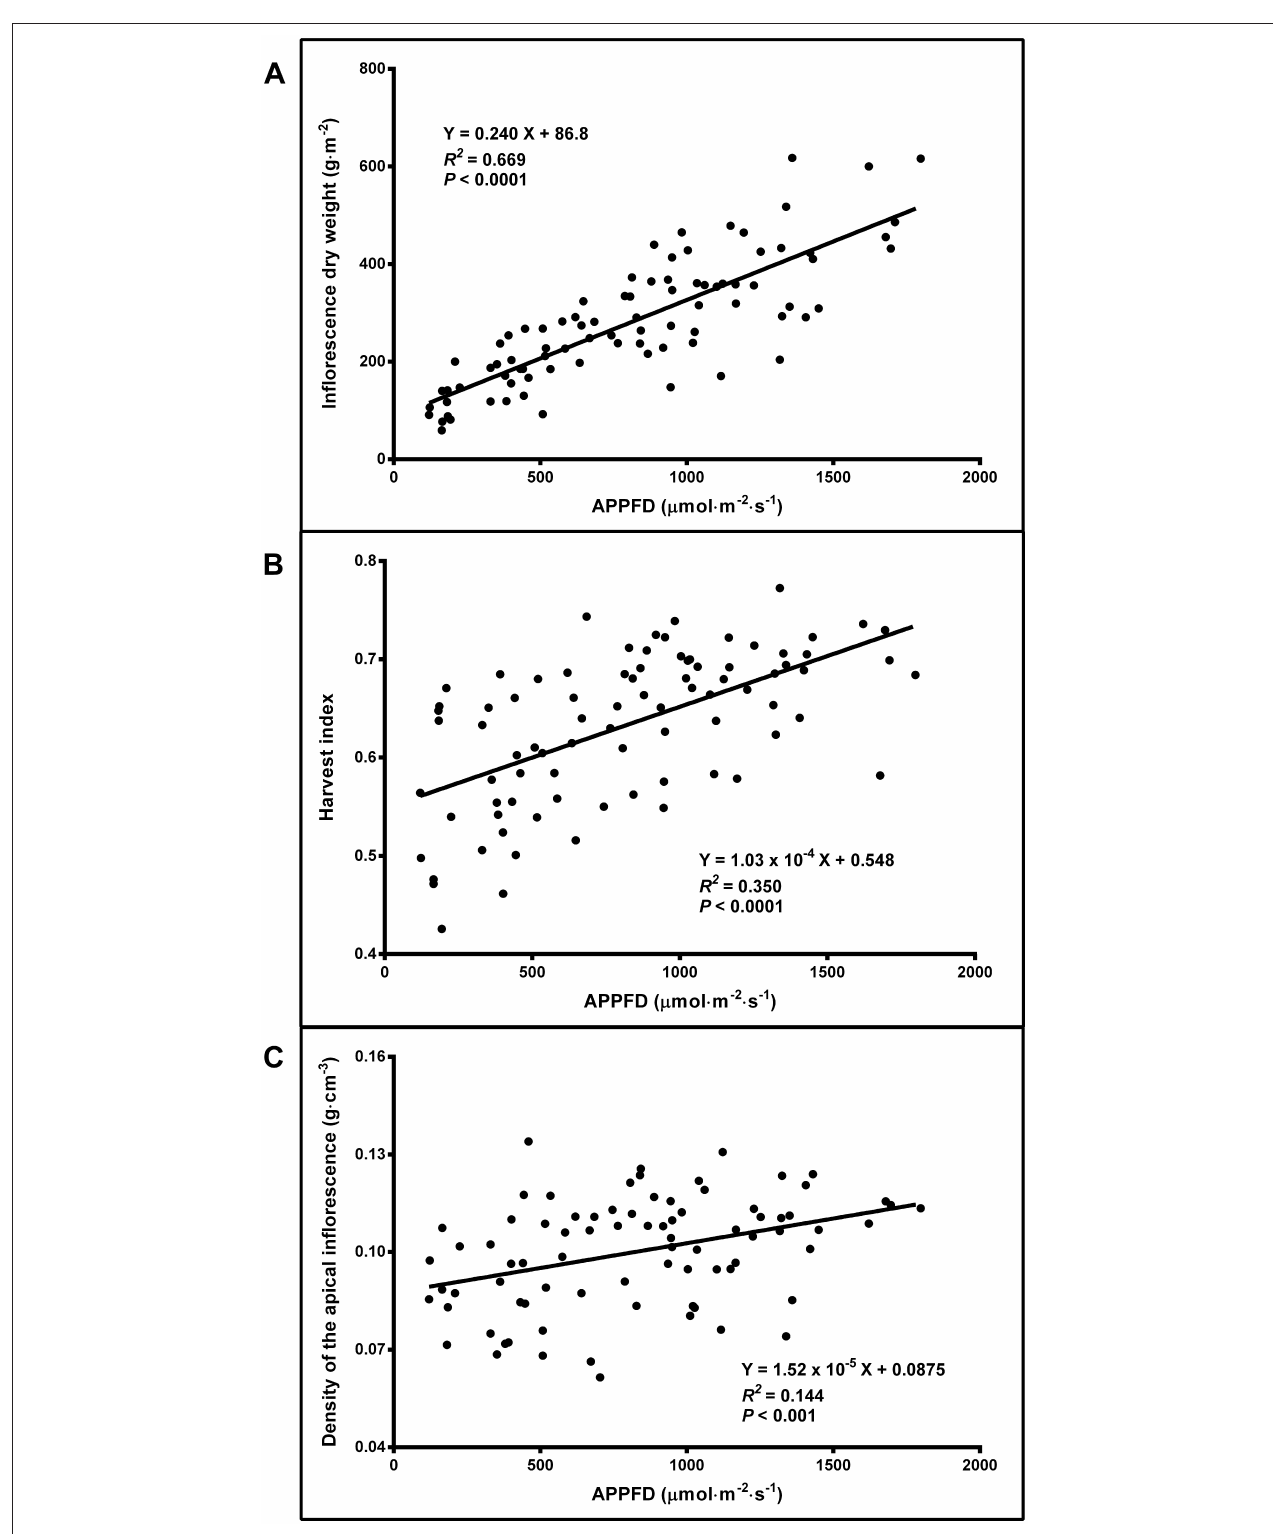
FIGURE 7 | The relationship between average apical photosynthetic photon flux density (APPFD) applied during the flowering stage (81 days) and inflorescence dry weight (A) , harvest index (total inflorescence dry weight / total aboveground dry weight) (B) , and apical inflorescence density (based on fresh weight) (C) of Cannabis sativa ‘Stillwater’. Each datum is a single